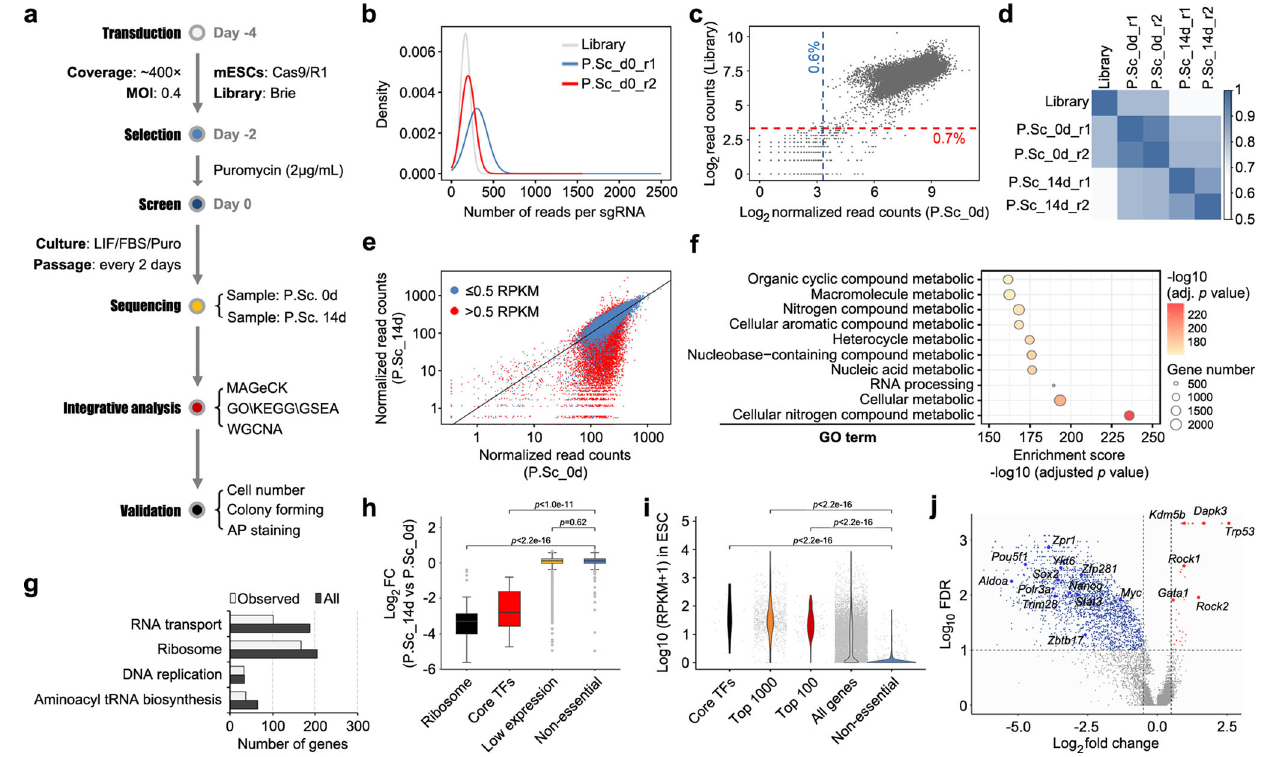
Fig. 1 CRISPR/Cas9-based knockout screen in mESC pluripotency maintenance. a Schematic of loss-of-function screening with the Brie library. b Distributions of the number of reads per sgRNA in the library (grey), and the P.Sc_d0_r1 (blue) and P.Sc_d0_r2 (red) samples. c Scatter plots comparing the sgRNA read counts in the plasmid library and P.Sc_d0 samples. Red and blue lines indicate that 0.7% and 0.6% of the sgRNAs have undetectable representations (less than 10 reads). d Heatmap of Pearson correlation coef fi cients among the library and the P.Sc_d0 (with two biological replicates r1 and r2) and P.Sc_d14 (with two biological replicates r1 and r2) samples. e Comparisons of gene read counts between the P.Sc_d0 and P.Sc_d14 samples. The red dots represent expressed genes (>0.5 reads per kilobase per million mapped reads (RPKM)), and the blue dots represent low-/non-expressed genes ( ≤ 0.5 RPKM) in mESCs. f Biological processes enriched in the negative selection genes. Top 10 enrichment terms are presented. g The column chart indicates the numbers of genes involved in the fundamental cellular processes. Observed, genes identi fi ed in negative selection. All, all the genes involved in the cellular processes (KEGG database). h The fold changes of the sgRNAs targeting the “ ribosome ” , “ core TFs ” , “ low expression ” and “ non-essential ” genes (Supplementary Data 4) in the P.Sc_d14 samples relative to the P.Sc_d0 samples. The data are represented as log 2 FC (fold change of sgRNA read count). p values were calculated using the Wilcoxon signed-rank test. i Expression levels of the “ core TFs ” , “ Top 1000 ” (top 1000 genes ranked by MAGeCK), “ Top 100 ” (top 100 genes ranked by MAGeCK), “ all genes ” and “ non-essential ” genes in mESCs (Supplementary Data 4). The values are represented as log 10 (RPKM + 1). p values were calculated using the Wilcoxon signed-rank test. j A volcano plot of the screen results. The blue/red dots indicate the negative/positive selection genes with an absolute sgRNA Log 2 fold change >0.5 and FDR <